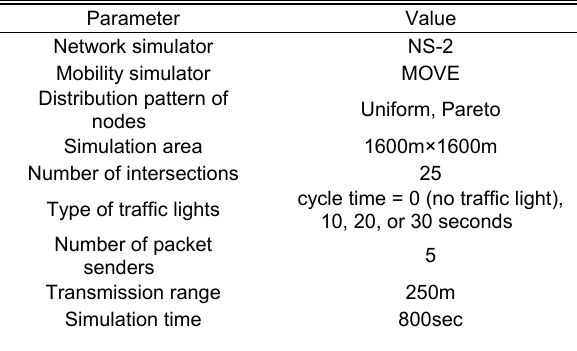
Table 2. Simulation